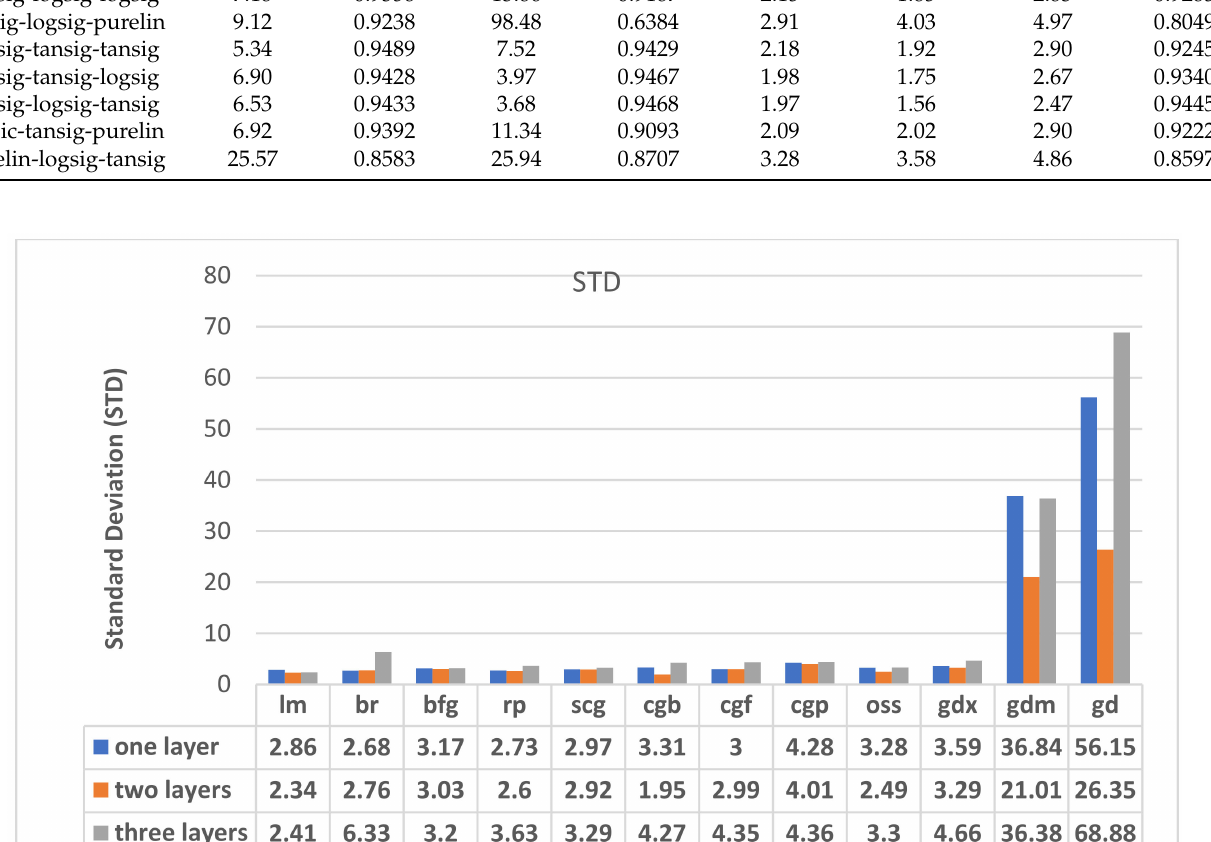
Figure 7. Standard deviation (STD) statistics with one, two and three layers of